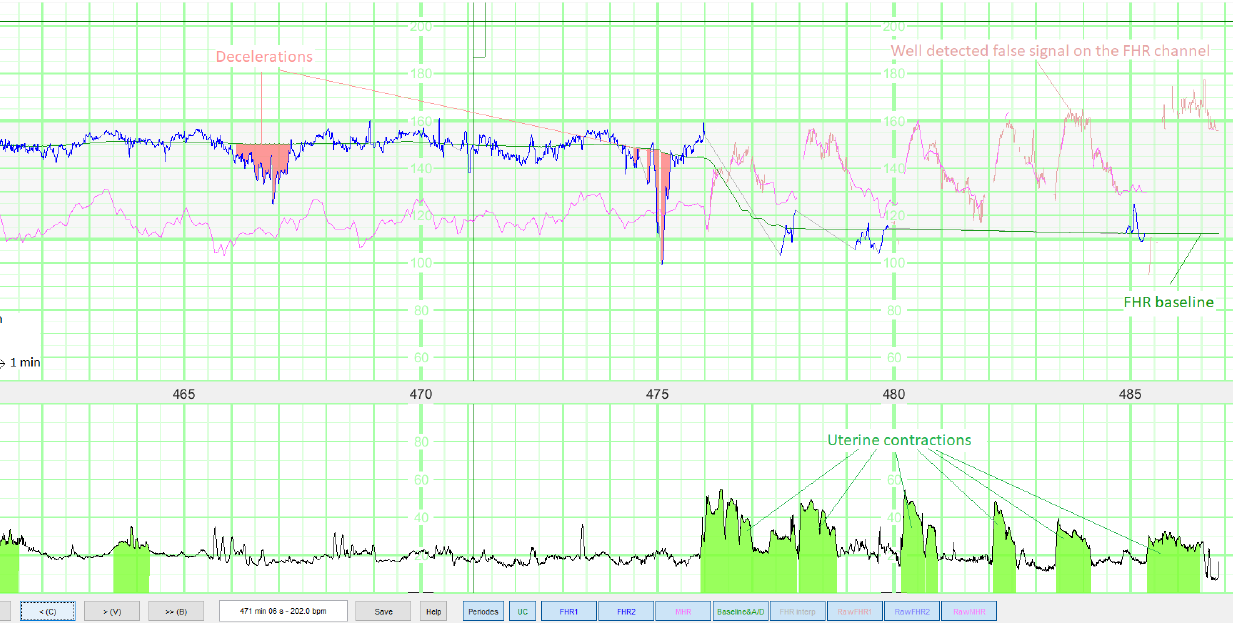
Figure 7. The FHRMA toolbox interface automatically displays both FSs and the results of a mor- phological analysis (baseline, accelerations, decelerations, and UCs). The FHR signal comes from the Doppler sensor. The second stage of delivery starts at 475